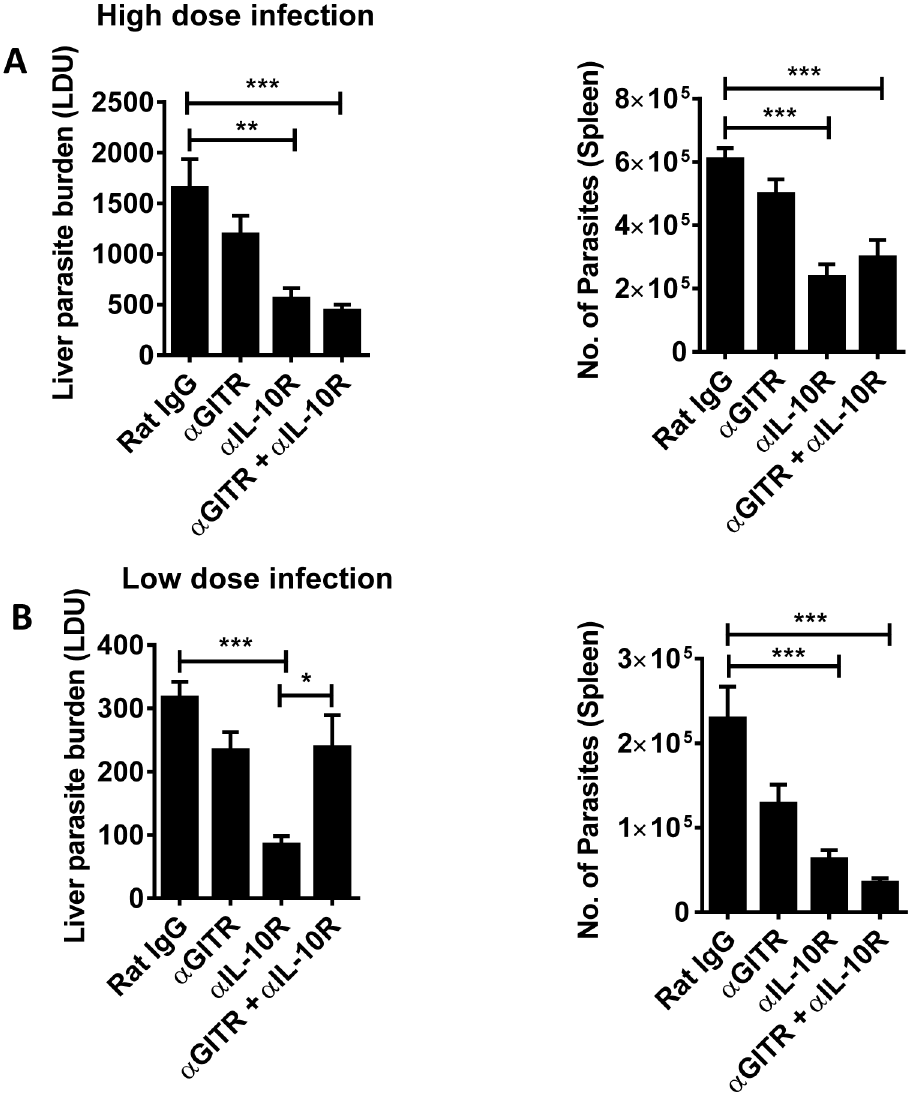
Fig 3. Parasite inoculum determines combination treatment outcome. Parasite burdens at day 28 p.i., were measured in the livers and spleens of mice, as indicated, infected with a high ( A ) or low ( B ) dose of parasite inoculum. Infected mice were treated with mAb alone or a combination of anti-GITR mAb on day 14 p.i., and anti-IL-10R mAb on days 14, 19 and 24 p.i.. Rat IgG was used as a control. Data are represented as the mean +/- SEM, and statistical differences of p < 0.05 ( * ), p < 0.01 ( ** ) and p < 0.001 ( *** ) are indicated (n = 15 mice per group from 3 independent experiments).